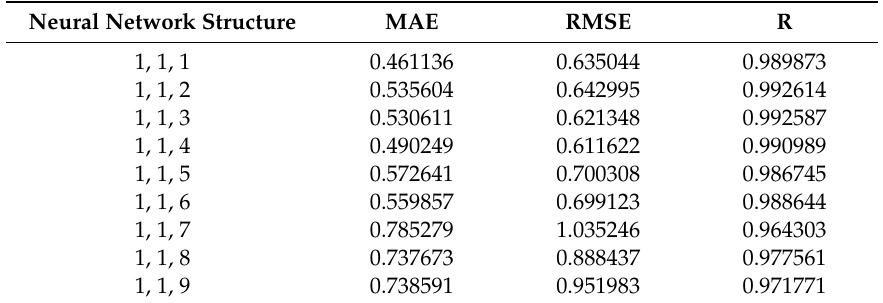
Table 6. Scores of model evaluation indexes with three hidden layers at di ff erent numbers of neurons. Neural Network